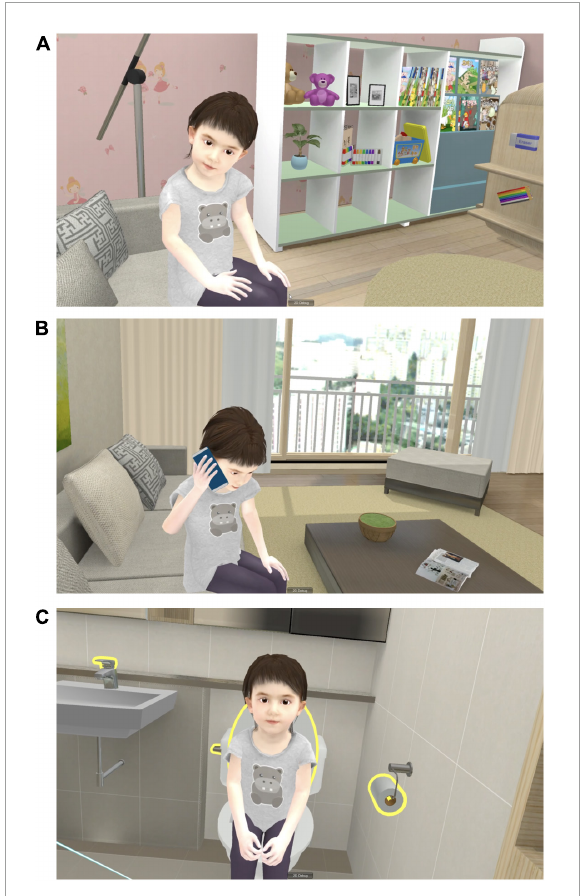
FIGURE1 Screenshots of VARABOM test. (A) In the “preparation recall” mission, the grandchild asks to find the preparation which was told before. (B) In the “phone call” mission, the grandchild asks to call her mother and tells the phone number. (C) In the “toilet use” mission, the grandchild asks to help her use